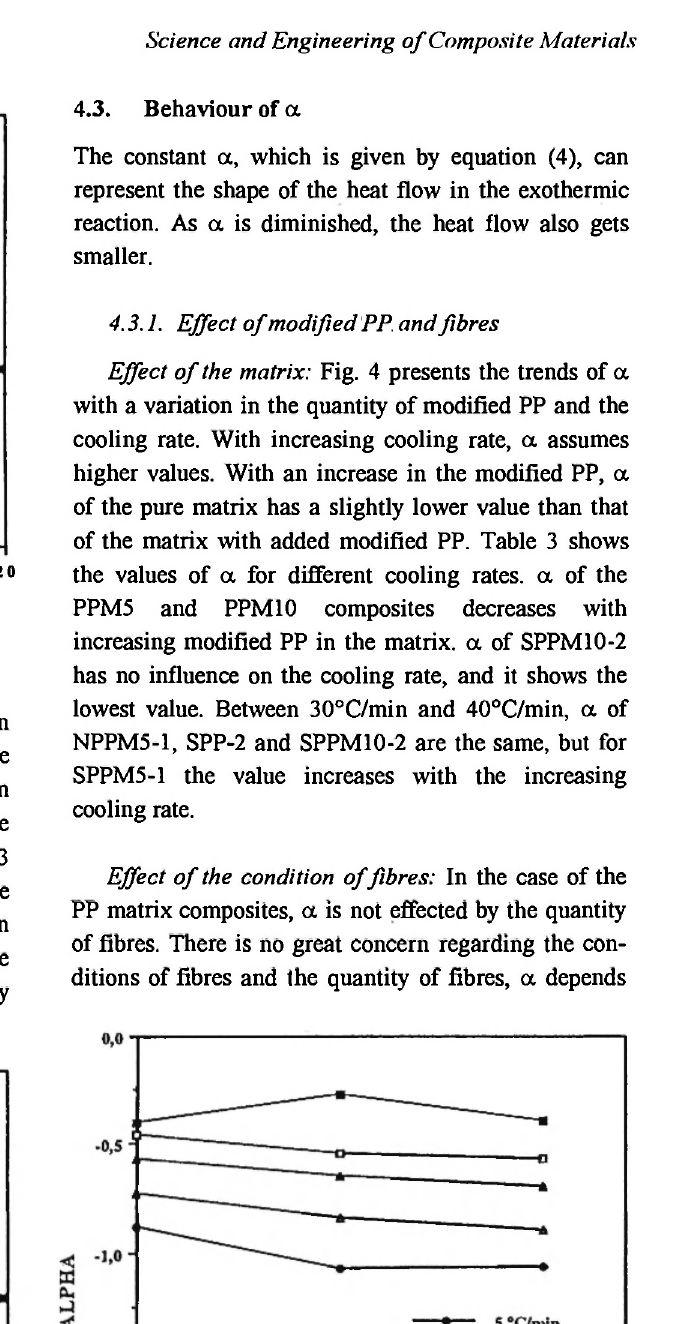
wt % of Fibers Trends of C 2 with the increase of fibers Fig. 3: